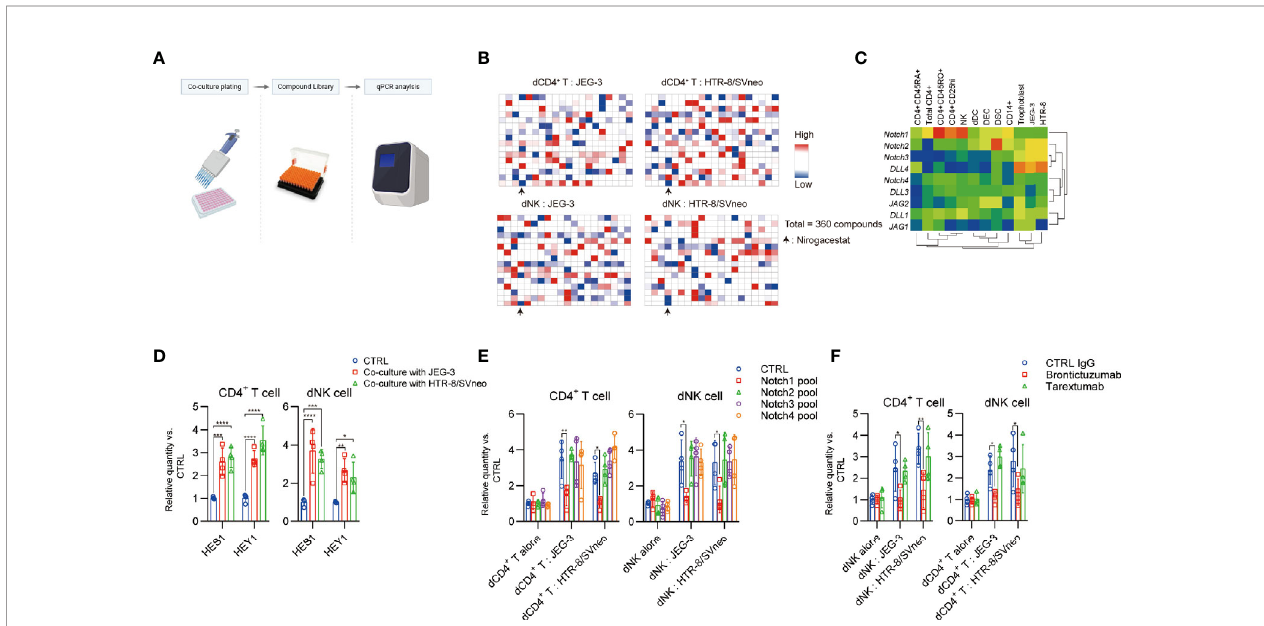
FIGURE 4 | Notch signaling is involved for TIGIT expression in decidual cells. (A) , Schematic view of drug screen. Figure created with BioRender.com (B) , Heat map generated from the transcript expression TIGIT as determined by quantitative polymerase chain reaction (qPCR) analysis. In order for the data to usefully predict antagonism or sensitivity, a criterion that only dates in the upper and down quarters was employed for hit selection. (C) , Heat map representing transcript expression of Notch receptors and ligands, as determined by qPCR analysis. (D) , dCD4 + T and dNK cells were cultured alone or co-cultured with indicated cells and select gene expression was determined by qPCR analysis. Gene expression was normalized to the housekeeping gene and expressed as fold of control cells, n = 4. (E) , dCD4 + T and dNK cells were transfected with a CTRL pool (CTRL-siRNA) and a pool of Notch siRNAs. After 48 h, the cells were then cultured in different methods with indicated treatment for 24 h days, and TIGIT expression was determined by qPCR analysis. Gene expression was normalized to the housekeeping gene and expressed as fold of control cells cultured alone, n = 4. (F) , dCD4 + T and dNK cells were cultured alone or co-cultured with indicated cells and treated with different antibodies. TIGIT expression was determined by qPCR analysis. Gene expression was normalized to the housekeeping gene and expressed as fold of control cells cultured alone, n = 4. Data are the means ± s.d and P values were from a two-way ANOVA followed by the Bonferroni post-test (D – F) . *: P < 0.05; **: P < 0.01 (E, F)